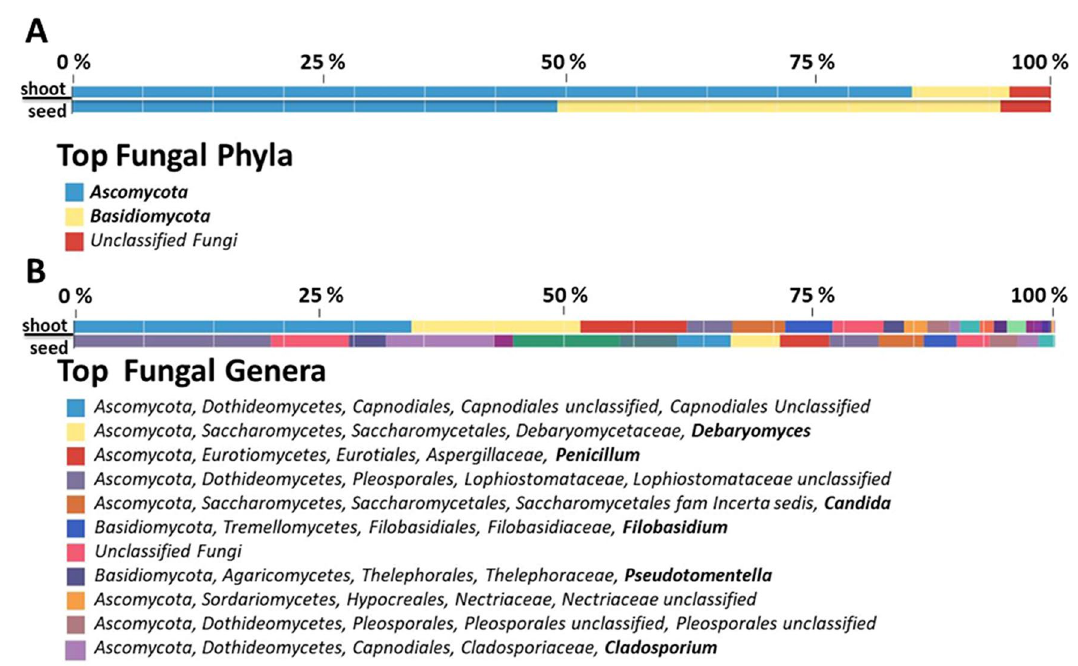
Figure 3. Relative quantification of fungal phyla ( A ) and genera ( B ) of C. limon seed and shoot microbiota, as detected by NGS sequencing. In panel B, fungal genera are highlighted in